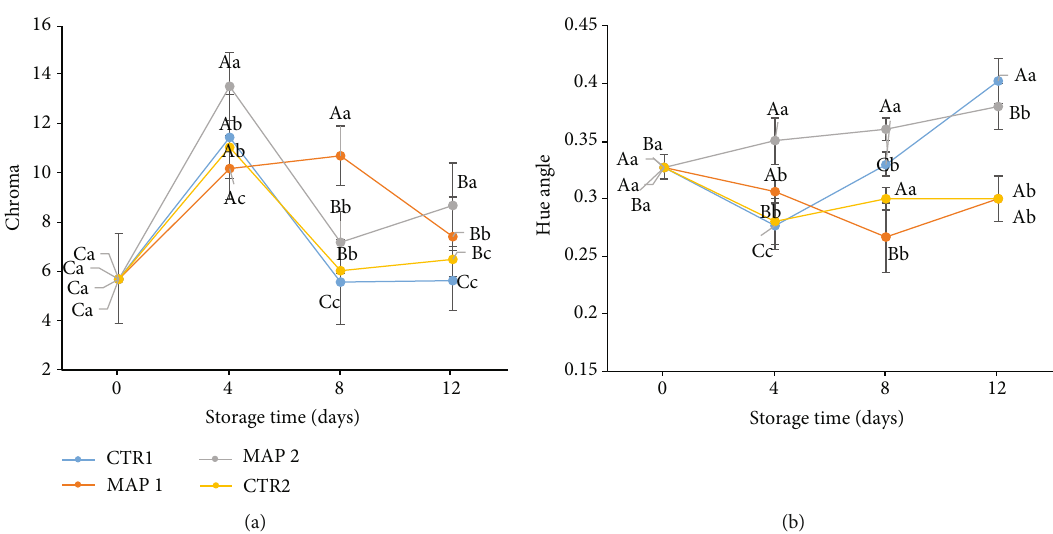
Figure 4: Color characteristics of mulberry fruit at 0, 4, 8, and 12 days of storage at 4 ± 1 ° C and 90 ± 5 % RH (relative humidity) after all treatments. (a) Chroma value. (b) Hue angle. Means ± SD with di ff erent letters are signi fi cantly di ff erent at p ≤ 0 : 05 using Tukey ’ s HSD test. Di ff erent lowercase letter denotes signi fi cant di ff erences ( p ≤ 0 : 05 ) among di ff erent treatments for the same sampling time. Letter “ a ” or “ A ” denotes the highest value. Di ff erent capital letters denote signi fi cant di ff erences ( p ≤ 0 : 05 ) among di ff erent sampling times for the same treatment. Letter “ a ” denotes the highest